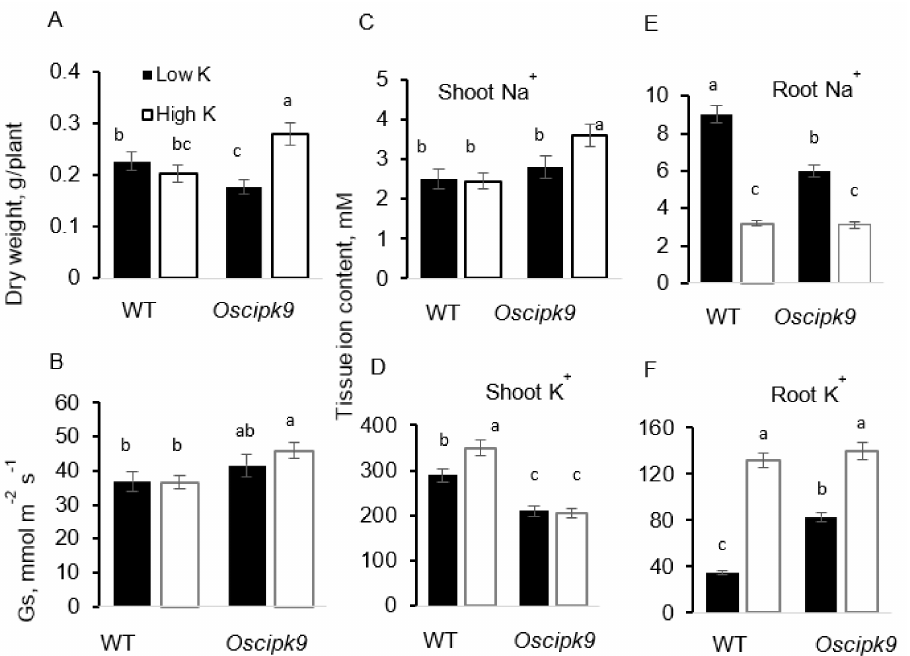
Figure 5. Effects of two K + availability on agronomical and physiological characteristics of WT Oscipk9 mutant plants. ( A ) plant dry weight; ( B ) stomatal conductance; ( C ) shoot Na + content; ( D ) shoot K + content; ( E ) root Na + content; and ( F ) root K + content. Closed bars—WT; open bars— Oscipk9 mutant line. Data are the mean ± SE ( n = 18). Data labelled with different low-case letters is significantly different at p <